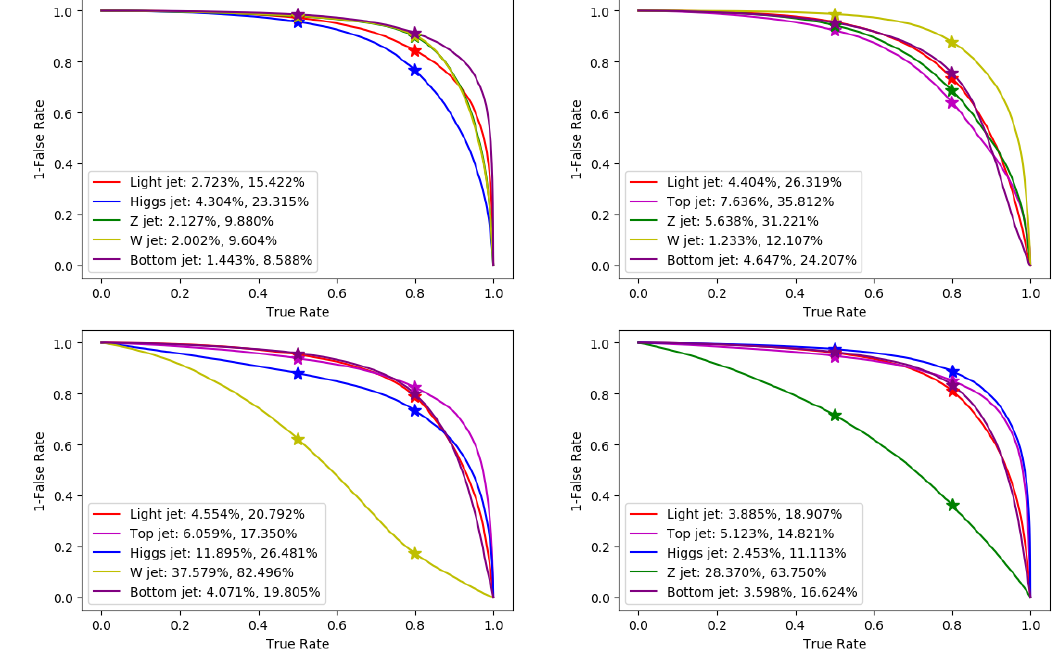
Figure 6 . Jet tagging performance for the (cid:12)rst region selection 400 < p fatjet curve. From the top left plot, we have the jat tagging e(cid:14)ciency for top, Higgs (top right), Z (bottom left) and W (bottom right) jet respectively. The y-axis are the 1 minus false rate. In the plot labels we display the miss identi(cid:12)cation for 50% and 80% benchmark points. pair of jet classes a and b , the ROC curve shows \tag e(cid:14)ciency" (probability of correctly tagging the jet of class a as a ) on the horizontal axis, and 1 (cid:0) mistag rate (the probability of incorrectly tagging jet of class b as a ) on the vertical axis. Benchmark working points used in the collider analysis correspond to 50% and 80% e(cid:14)ciency for the relevant jet class ( t , H , or W=Z , depending on the analysis). These benchmark points are labeled on each of the curves, and the corresponding mistag rates are listed in the plot